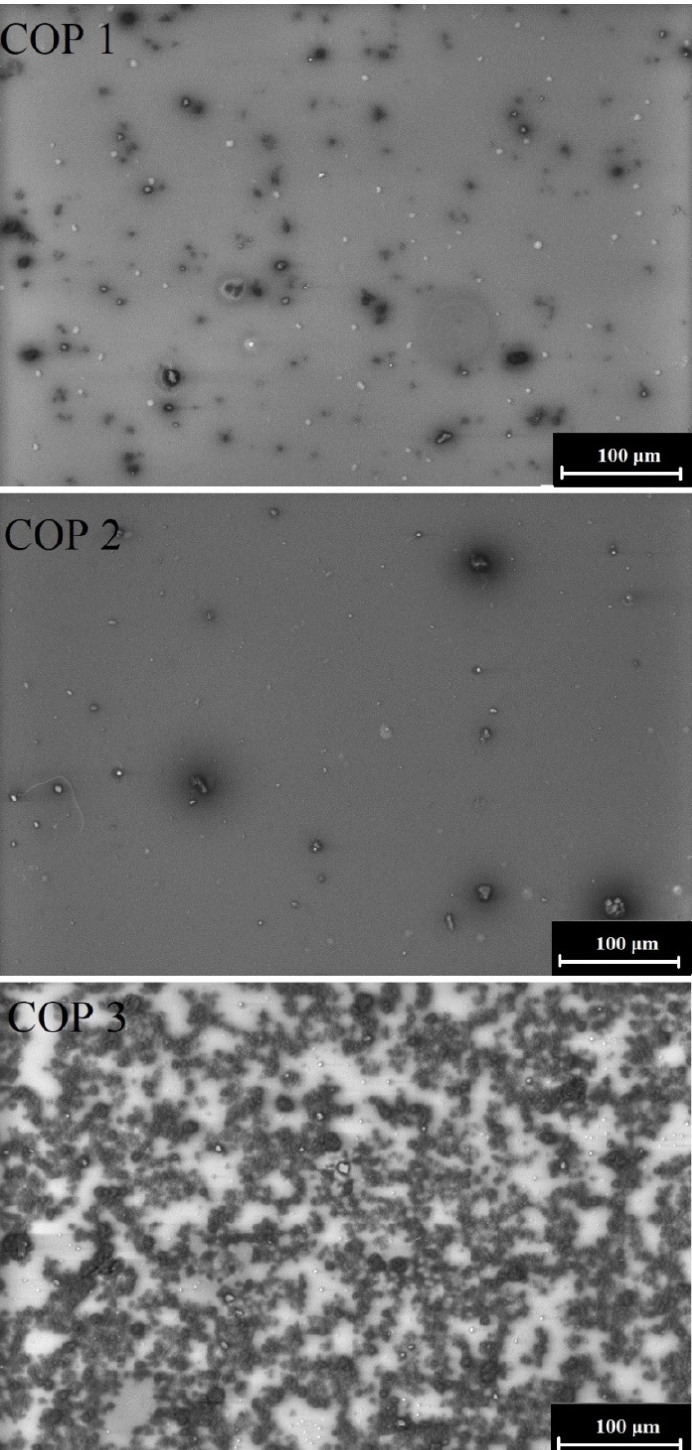
Figure 6. SEM of styrylquinoline copolymers.